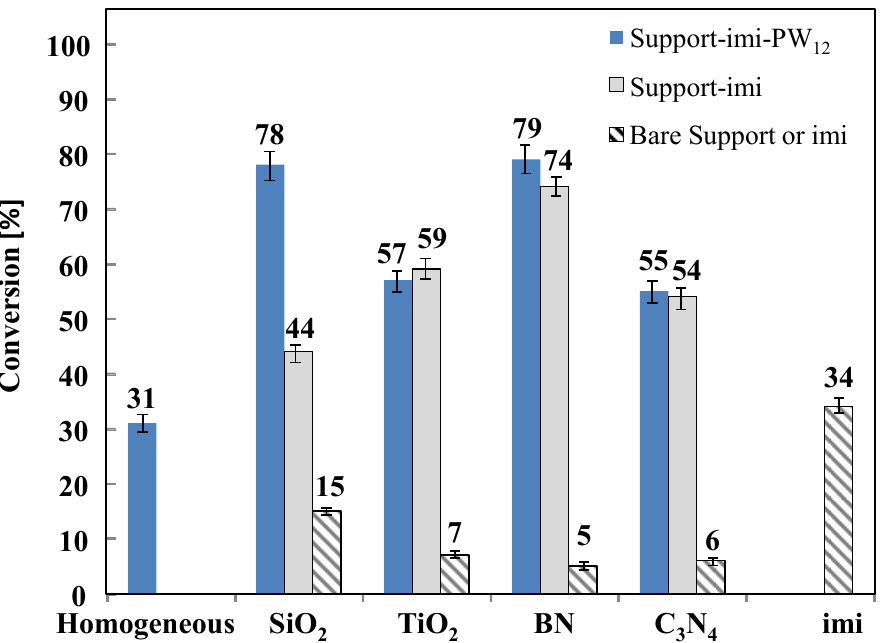
Figure 6. Conversion of fructose for catalytic reactions carried out in aqueous medium at 165 °C for 3 h in the presence of the different catalysts. Initial fructose concentration 0.3 M at natural pH.